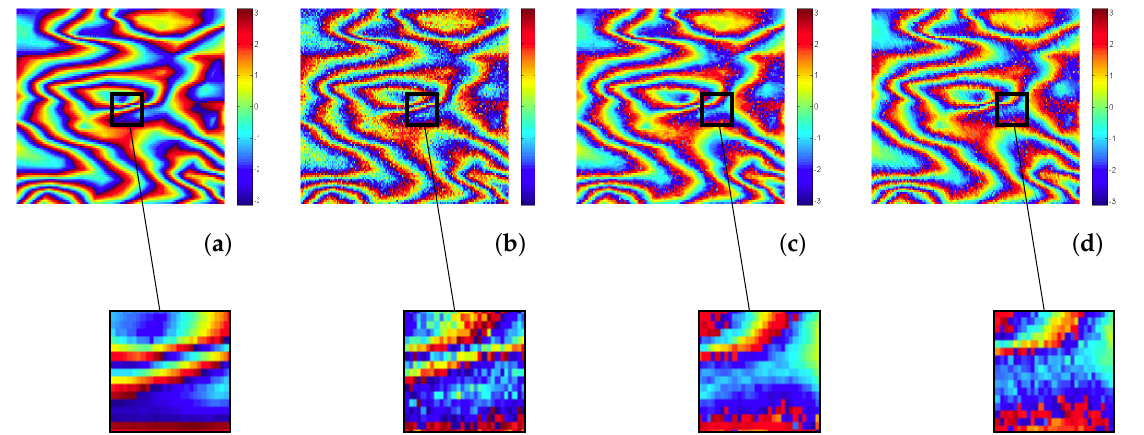
100 patch from Figure 6: ( a ) simulated fringe pattern ( X ); ( b ) noisy Figure 7. Top: Extracted 100 × interferogram with σ ν = 0.5; ( c ) denoised interferogram obtained by K-SVD; ( d ) denoised interferogram obtained by ProK-SVD. Bottom: some close-ups.